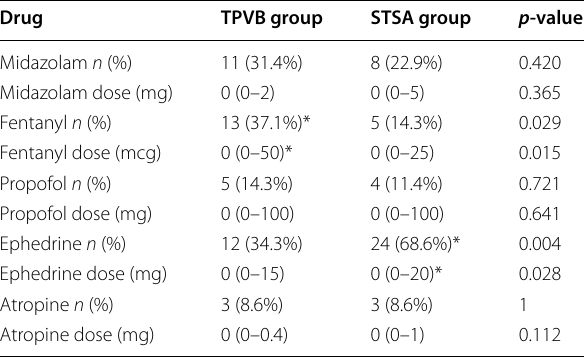
Table 5 The intraoperative anesthetic drug requirements: incidences and doses